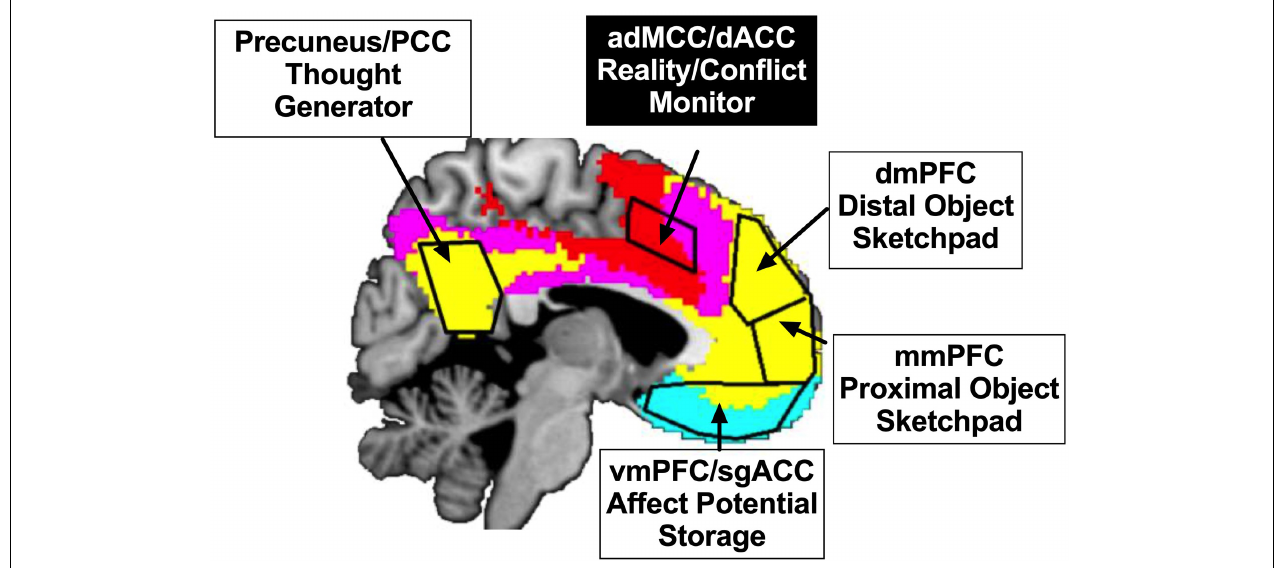
FIGURE 3 | Affect-object generative inference and regulation (AGIR) model, adapted from Ho and Nakamura (2017). There are two systems in the model. In the first system, an affect-object inference generation system encompasses four components: a thought generator in precuneus/posterior cingulate cortex (PCC), an affect potential storage in subgenual anterior cingulate cortex (sgACC) for negative affect and ventromedial prefrontal cortex (vmPFC) for positive affect, a proximal object sketchpad in middle medial prefrontal cortex (mmPFC), and a distal object sketchpad in dorsomedial prefrontal cortex (dmPFC). When “vehicles” of conceptual thoughts are running in this system, thoughts of affect-objects can be represented as mental objects (e.g., self = proximal objects charged with affective potentials; other = distal objects charged with affective potentials). In the second system, a cognitive control system encompasses a component of reality/conflict monitoring in anterior dorsal middle cingulate cortex (adMCC)/dorsal anterior cingulate cortex (dACC) and other cortical components not depicted in the figure. The main function of reality/conflict monitoring is to pause an ongoing affect-object generating thought and observe all modalities of information involved in a potential conflict, allowing an unrealistic expectation generated in the first system to be paused and updated. In terms of cortical networks that are self-organized in intrinsic resting-state functional connectivity in Yeo et al. (2011), the first system primarily involves Default Mode Network (yellow) and Cortical Limbic Network (cyan), and the second system primarily involves Ventral Attention Network (red) and Frontal-Parietal Network (violet). The colors of the components’ text boxes are reversed between the two systems, indicating an anti-correlative relationship between them. The demarcation of the brain areas is